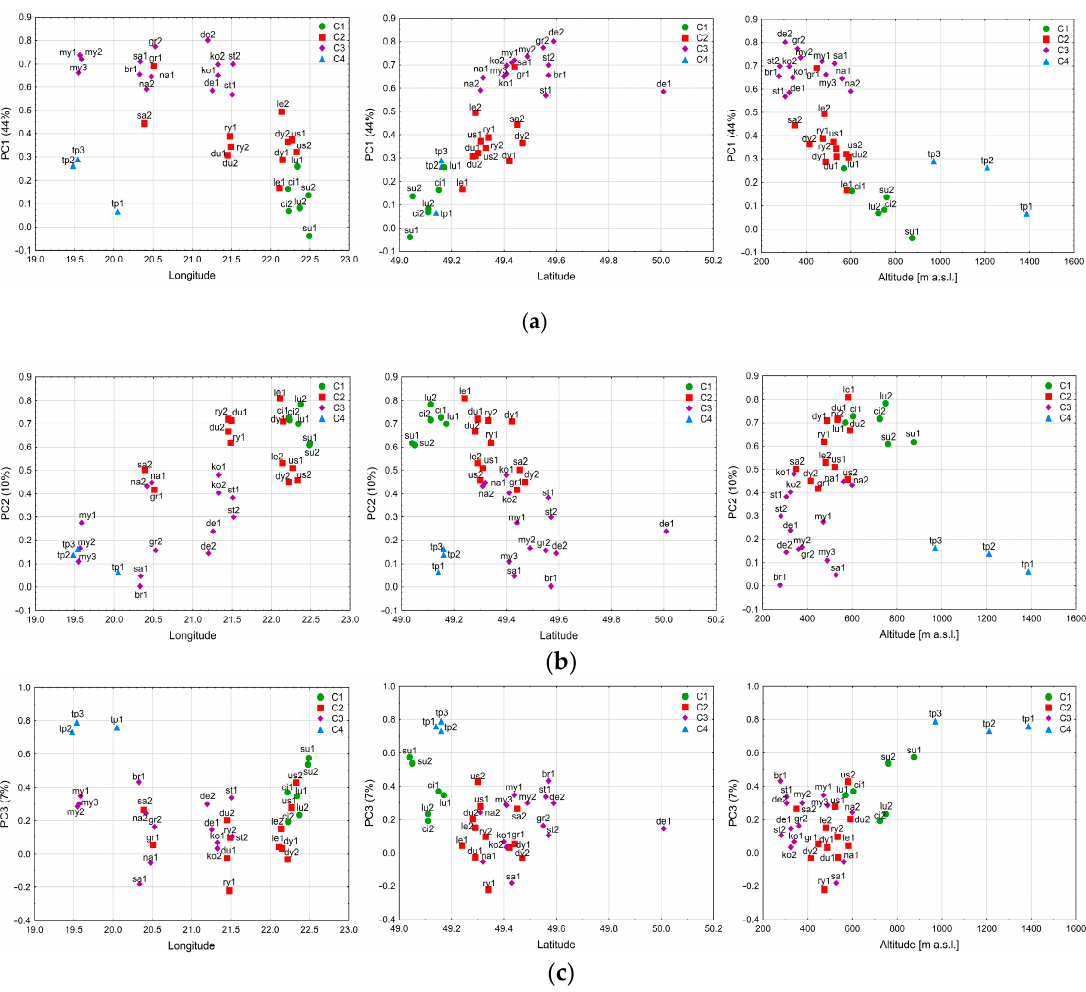
Figure 5. Plot of the relationship between the three first PCs and site longitude, latitude, and altitude. Sites and clusters are marked. ( a ) PC1; ( b ) PC2; ( c ) PC3.